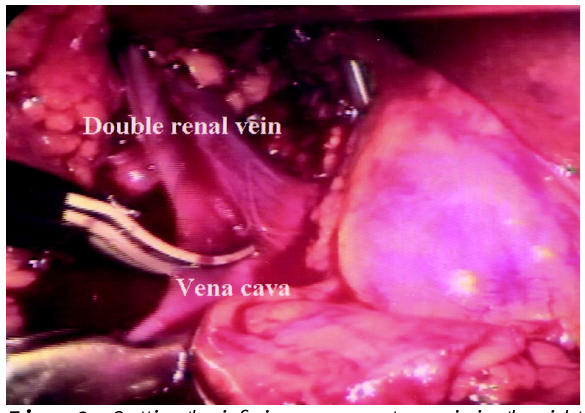
Figure 2 – Cutting the inferior vena cava to maximize the right renal vein length.